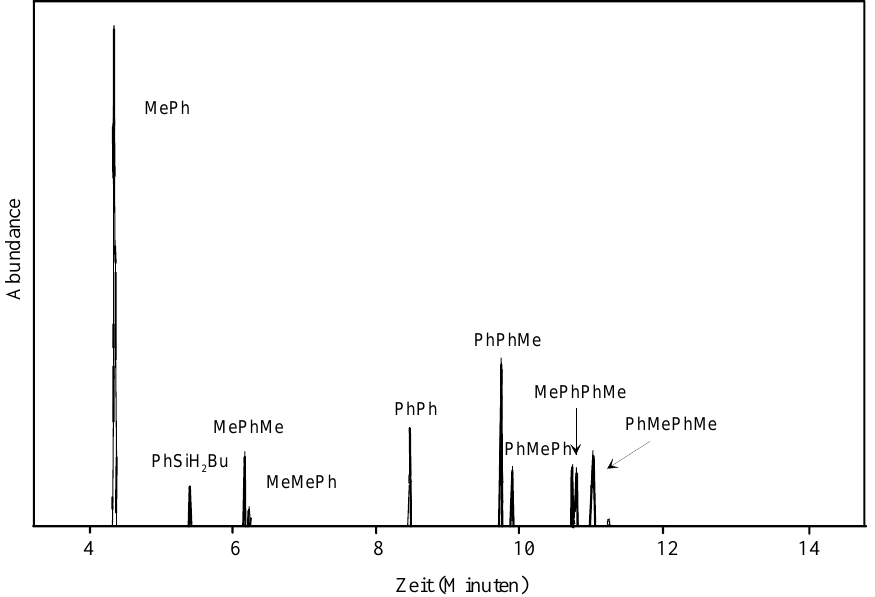
Figure 2. GC/MS analysis of an early stage of the homo-polymerization of 1-methyl-2- phenyldisilane.